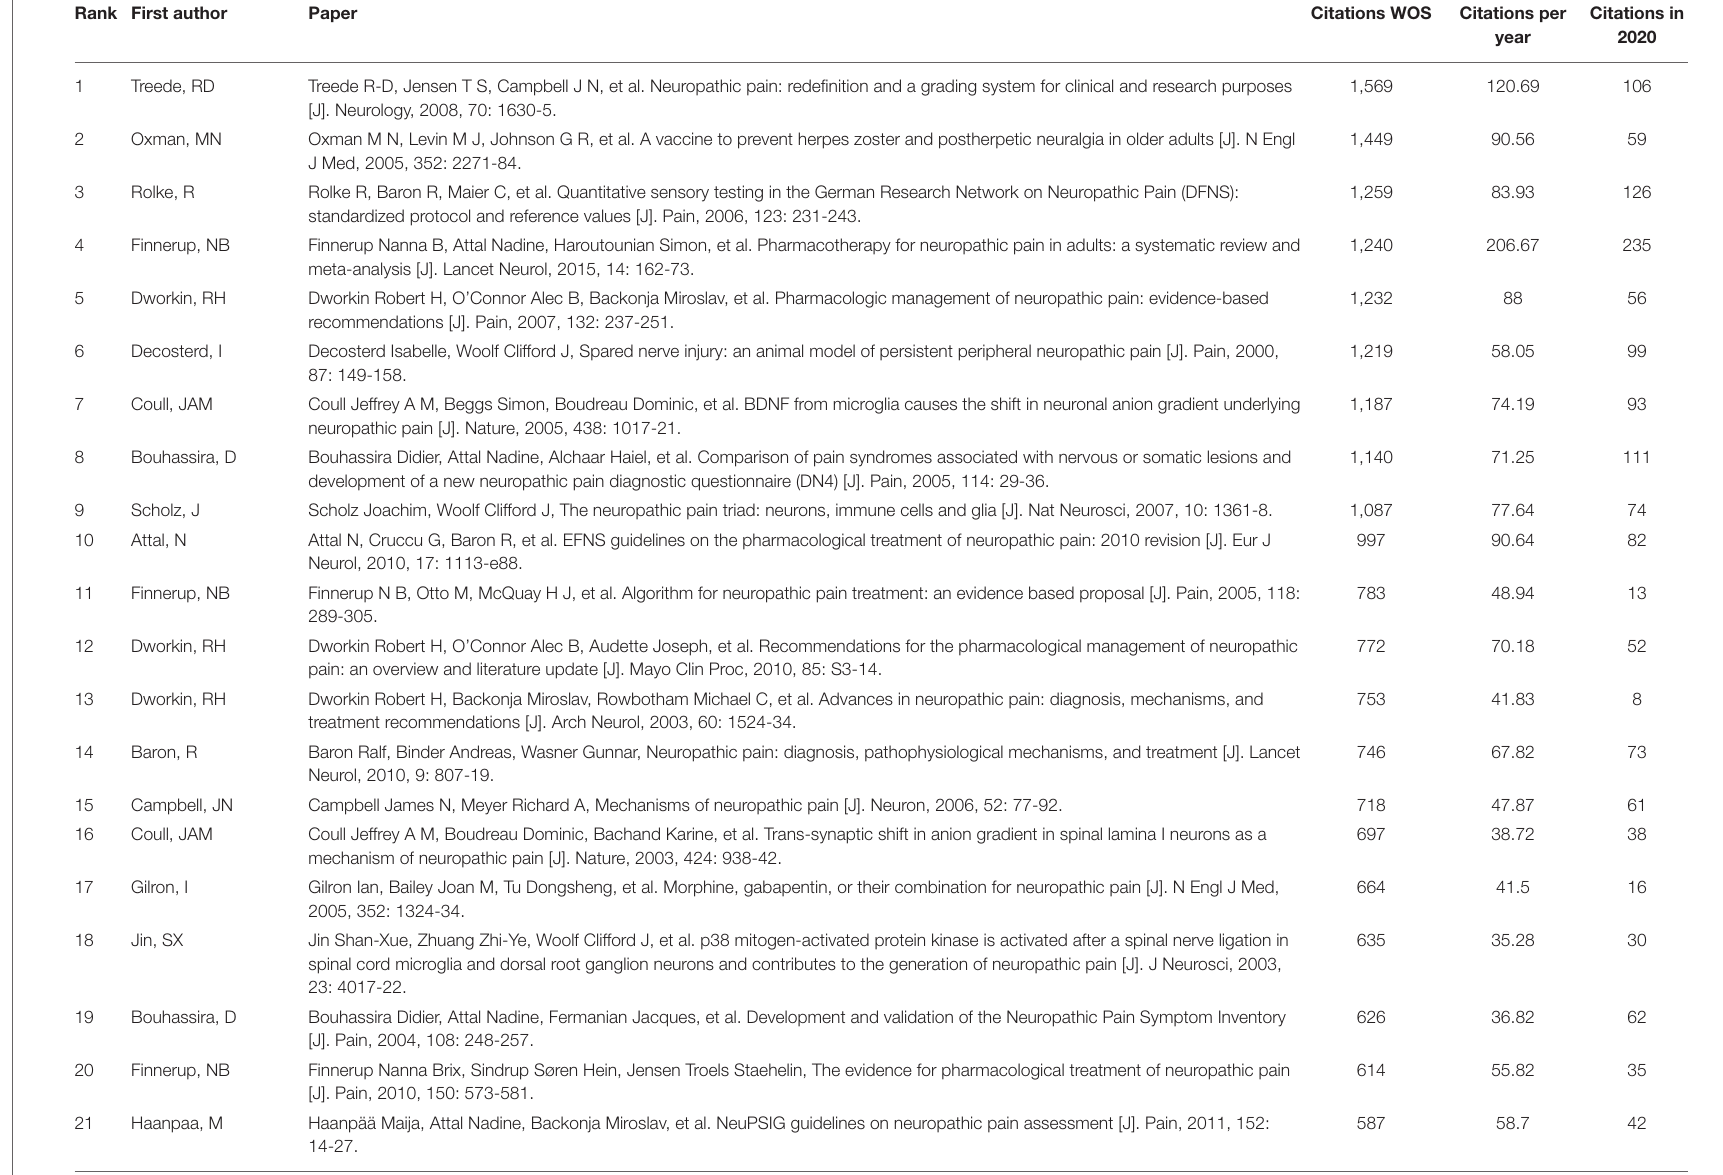
TABLE 1 | The 100 most-cited papers in Neuropathic pain